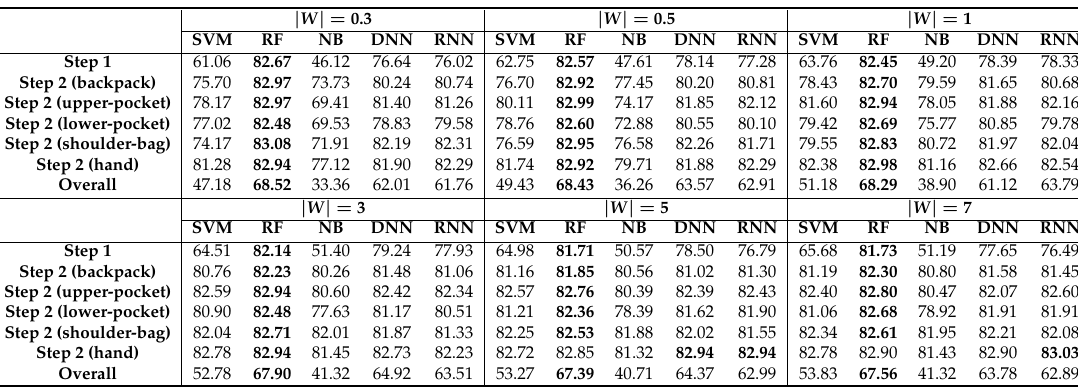
Table 3. Accuracies of possession-action recognition for different lengths of